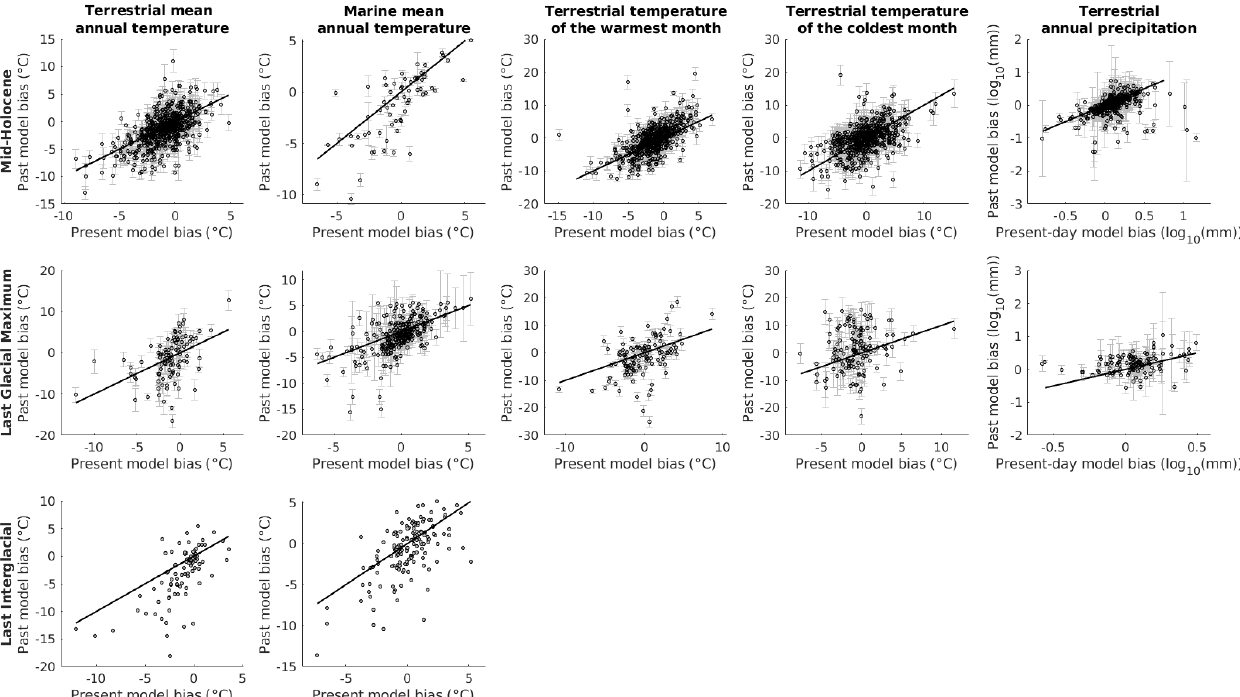
Figure A1. Comparison of present-day and past model biases (which the delta method assumes to be similar) from locations where empirical reconstructions are available. Lines represent 1:1 relationships.